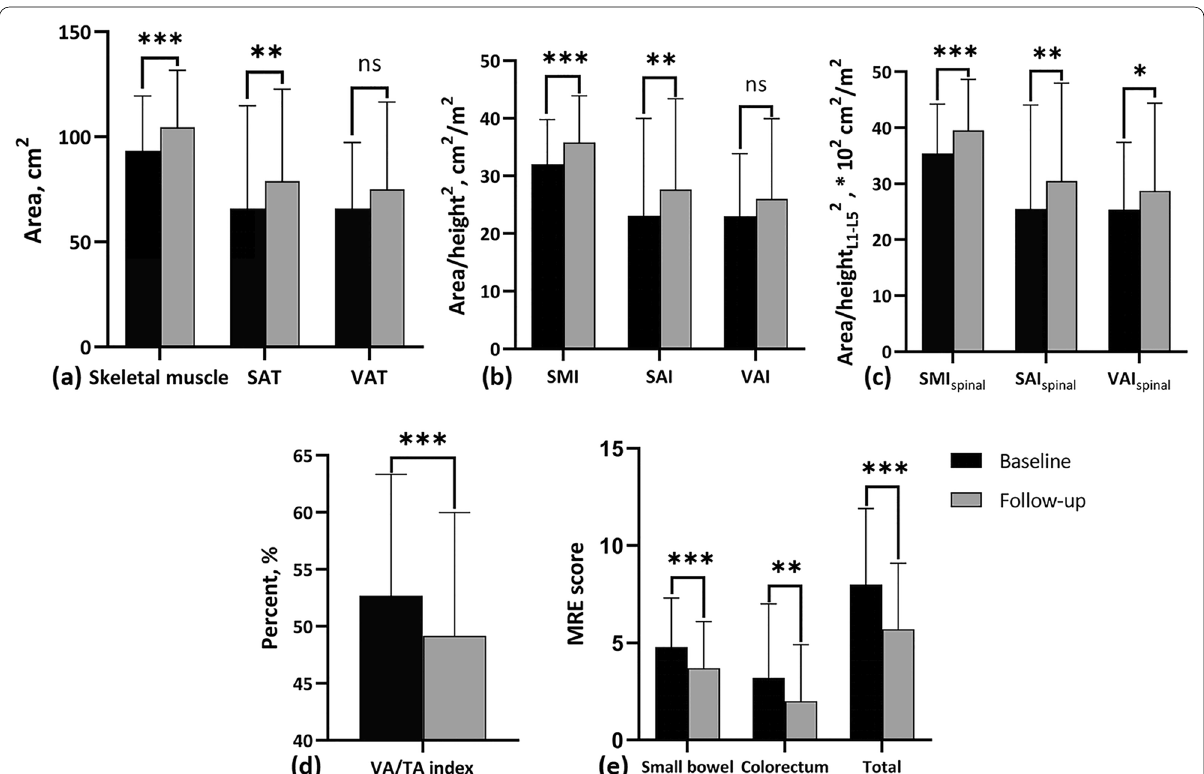
Fig. 4 Bar graphs of body composition parameters and MRE scores for all cases. Black bars represent baseline data, and grey bars represent follow-up data. a Area of skeletal muscle, SAT, and VAT at baseline and follow up; b Value of SMI, SAI, and VAI at baseline and follow up; c Value of SMIspinal, SAIspinal, and VAIspinal at baseline and follow up; d Value of VA/TA index at baseline and follow up; e MRE scores of small bowel and colorectum at baseline and follow up. ***: p < 0.001, **: p < 0.01, *: p < 0.05, ns: p > 0.05 (not significant); SAT: subcutaneous adipose tissue, VAT: visceral adipose tissue, SMI, skeletal muscle index; SAI, subcutaneous adipose index; VAI, visceral adipose index; SMI spinal , skeletal muscle area normalized by lumbar spinal height 2 ; SAI spinal , subcutaneous adipose tissue area divided by lumbar spinal height 2 ; VAI spinal , visceral adipose tissue area divided by lumbar spinal height 2 ; ns, no significant difference; VA/TA index, VAT to total adipose tissue